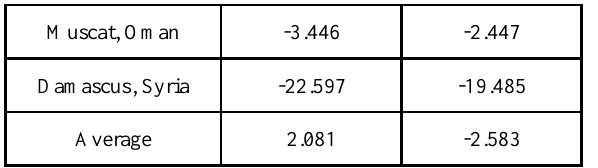
Table 7. Timing/Pointing Errors for HPT-R